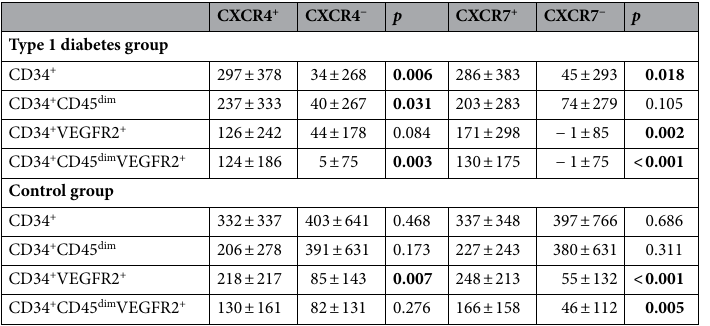
Table 2. Mean delta change (Δ) in pre to post-exercise cell numbers of HPCs and EPCs expressing CXCR4 and CXCR7 versus those negative for CXCR4 and CXCR7 for the type 1 diabetes and control groups. Bold signifies p ≤ 0.05. Data presented as mean ± SD. P value from dependent samples